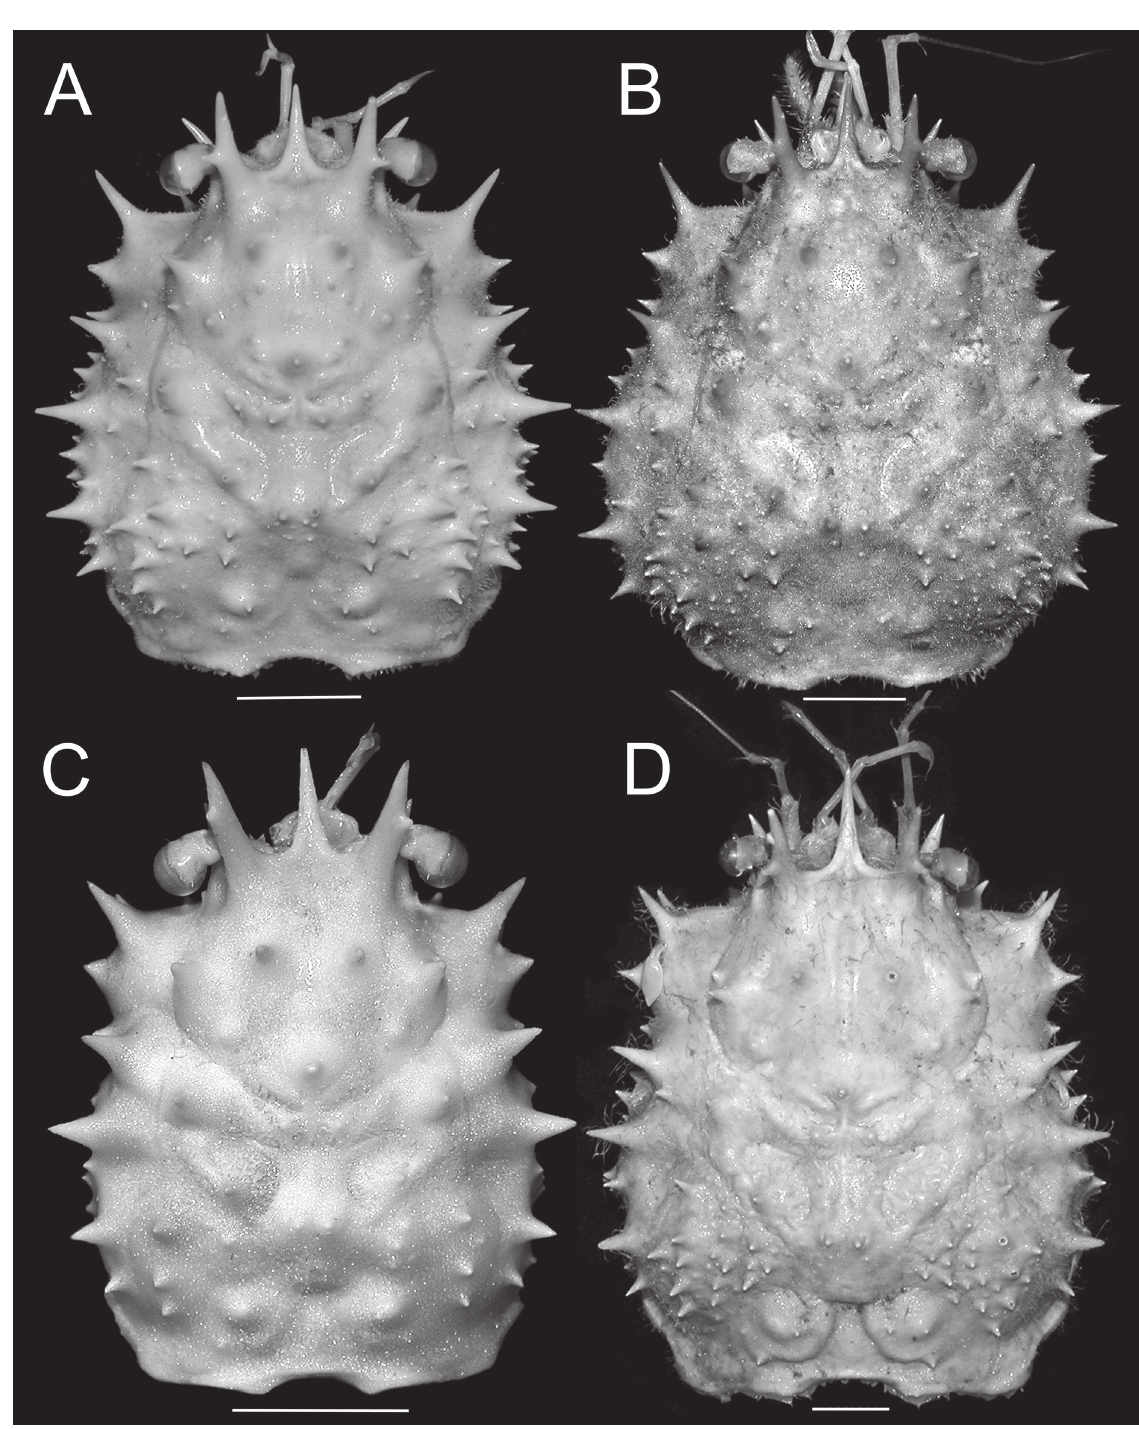
Fig. 3. Dorsal view of carapace. A . Moloha grandperrini Guinot & Richer de Forges, 1995. Holotype, ♂ (cl 46.5 mm, cw 39.0 mm) (NHM 1948.9.7.27), Maldives. B . Moloha tumida sp. nov. Holotype, ♂ (cl 55.7 mm, cw 50.6 mm) (DABFUK), Kerala, India. C . Moloha alisae Guinot & Richer de Forges, 1995. Holotype, ♂ (cl 36.1 mm, cw 29.7 mm) (MNHN-IU-2008-11077), Seychelles. D . Moloha alisae Guinot & Richer de Forges, 1995. ♂ (cl 67.7 mm, cw 56.2 mm) (ZRC 2008.1250a), South Africa. Scale bars = 10